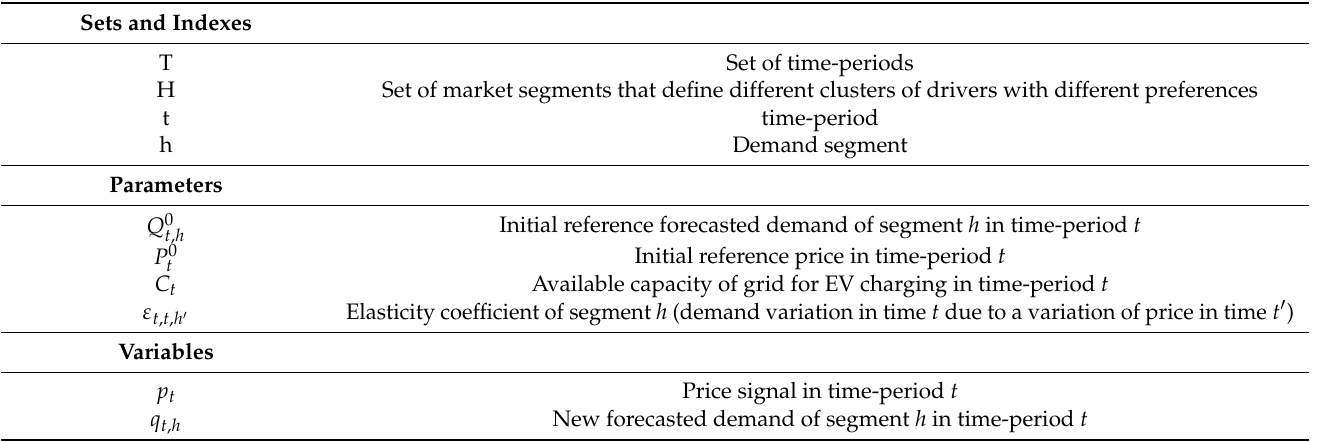
Table 1. Nomenclature